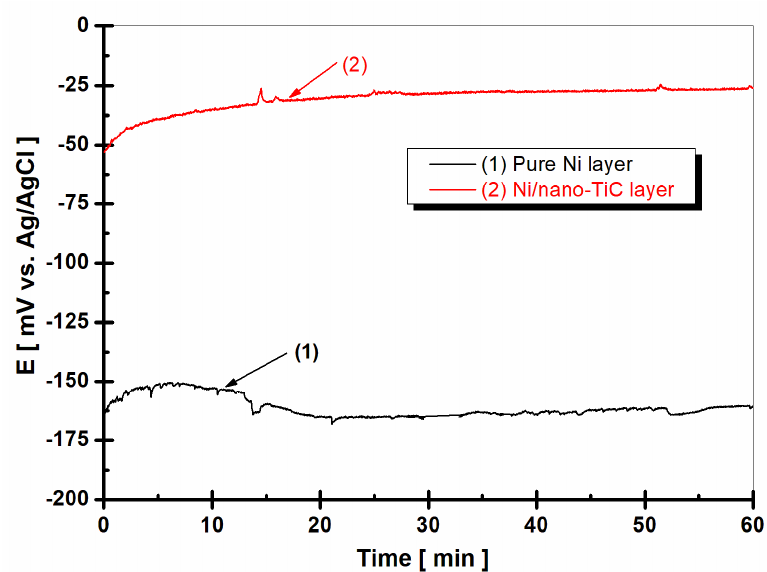
Figure 4. Evolution of the free potential (OCP) during 1 h of immersion in H 3 BO 3 -LiOH solution: (1) pure Ni layer; (2) Ni/nano-TiC layer.